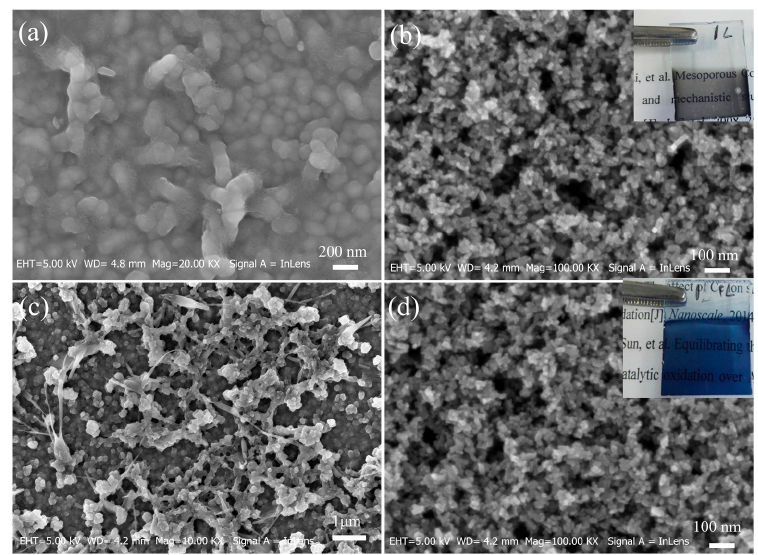
Figure 2. SEM images of ( a ) PPy film, ( b ) PPy@TiO 2 film, ( c ) PEDOT film, and ( d ) PEDOT@TiO 2 film (the inserted images in b, d are the photographs of PPy@TiO 2 and PEDOT@TiO 2 films, respectively).